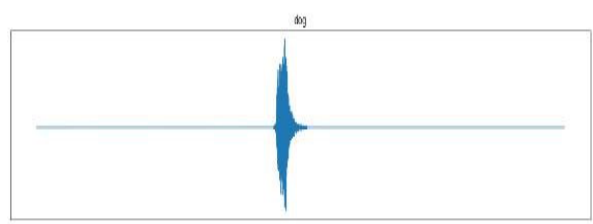
Fig. 8. Dog spectrogram without any distortion (audio clip with removal of external noise)